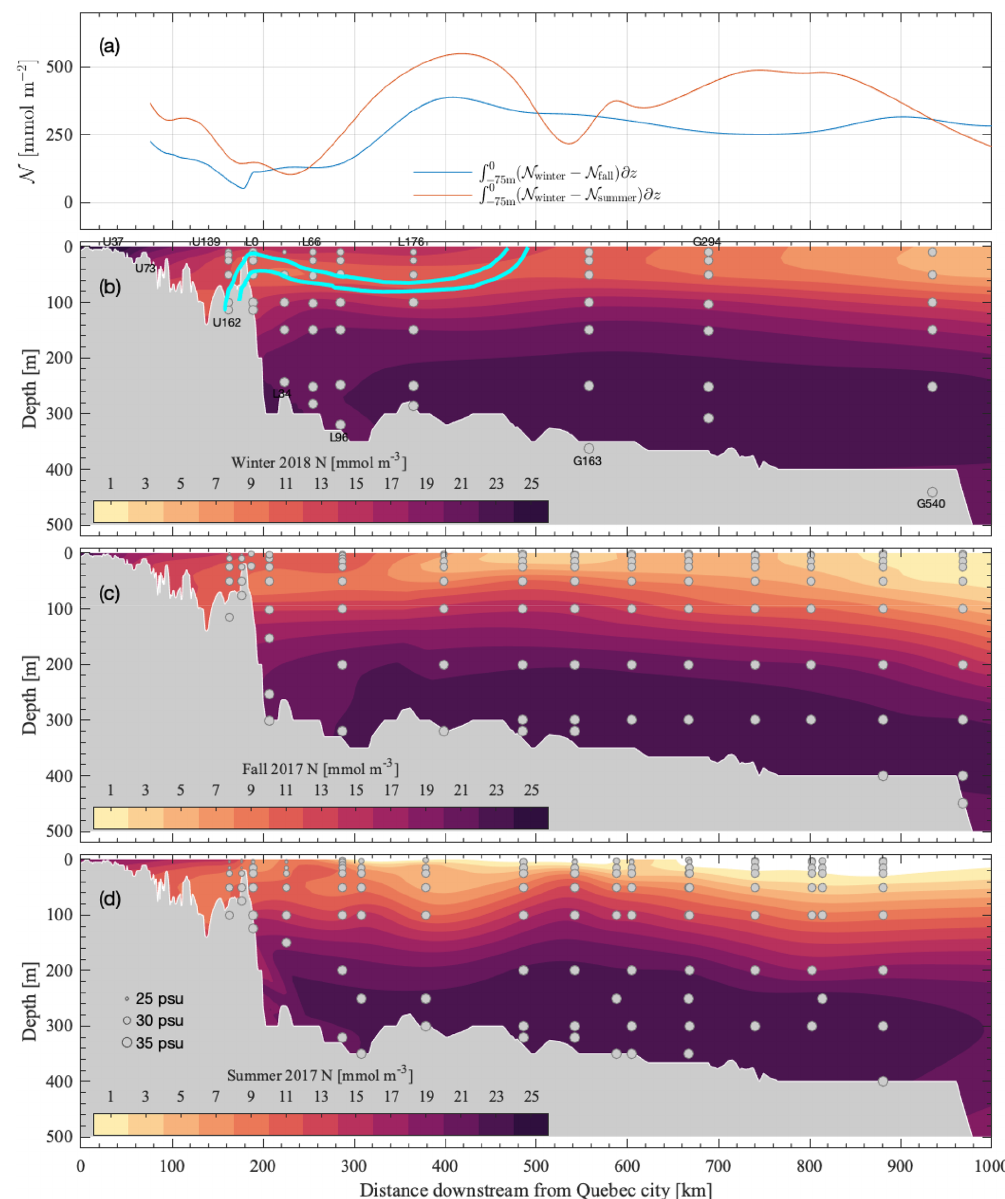
Figure 5. (a) Nutrient inventory generated in the upper 75m of the lower estuary’s water column. (b) Nitrate concentrations during our winter field campaign, (c) fall 2017, and (d) summer 2017 monitoring surveys. The thick cyan lines in (b) denote the same water masses as in Fig. 3. Water between these two lines coincides with the subsurface nitrate minimum at station L0 and downstream. The gray circles are scaled with the salinity of the water samples as shown in Fig. 4. The contours were obtained using a data-interpolating variational analysis (DIVA) technique (Troupin et al.,